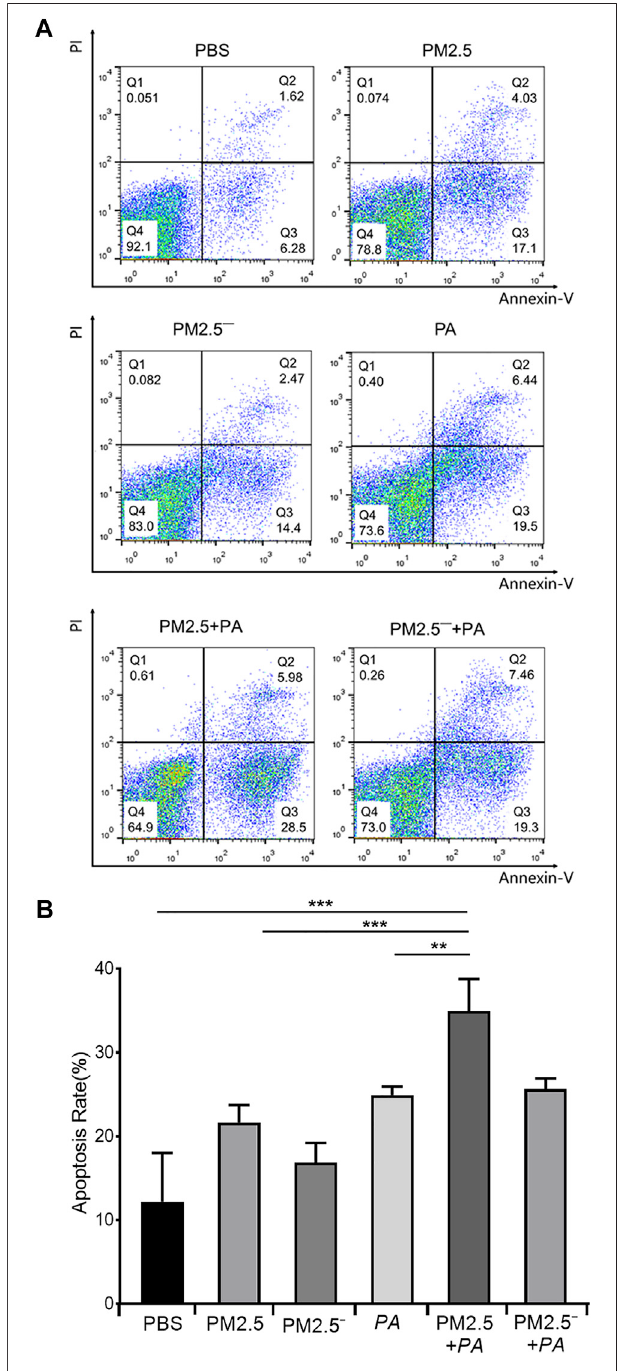
FIGURE 2 | Costimulation by PM2.5 and P. aeruginosa can aggravate the apoptosis of mouse alveolar macrophages. (A) Flow cytometry was used to detect apoptosis in each group after 12 h of stimulation with the samples. (B) The proportion of apoptotic cells in each group. In the experimental groups, the fi nal concentration of the PM2.5 and PM2.5 — samples was 100 μ g/ml, and the multiplicity of infection (MOI) between P. aeruginosa and the cells was 10:1 (number of bacteria:number of cells). Each group was stimulatedfor12 hwiththecorrespondingsample,andthecontrolgroupwas treated with an equal volume of PBS. The experiment was repeated three ( Continued